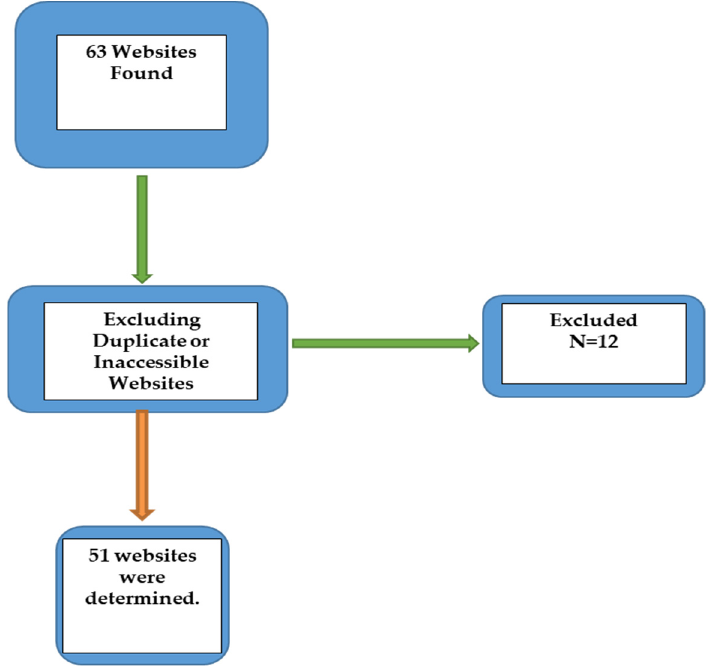
Figure 1. Flowchart of our study.